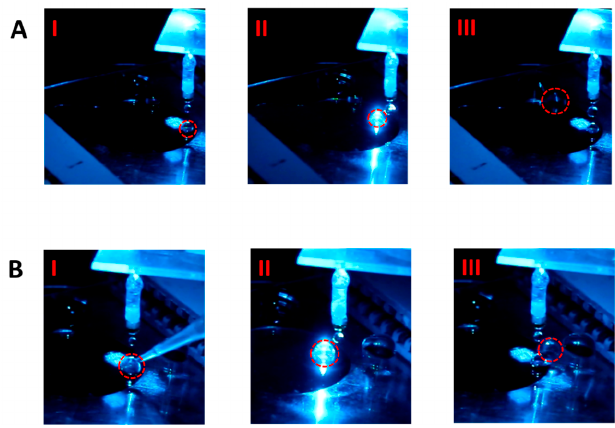
Figure 3. Droplet advancement images. ( A ) Non-fluorescent droplet. Snapshot I, droplet dripped at the inlet channel entrance; snapshot II, driven to the detection zone; snapshot III, reached the waste zone; and, ( B ) fluorescent droplet. snapshot I, droplet dripped at the inlet channel entrance and filled with fluorescent microparticles via a pipette tip; snapshot II, driven to the detection zone to emit fluorescence; snapshot III, diverted to the collection channel.